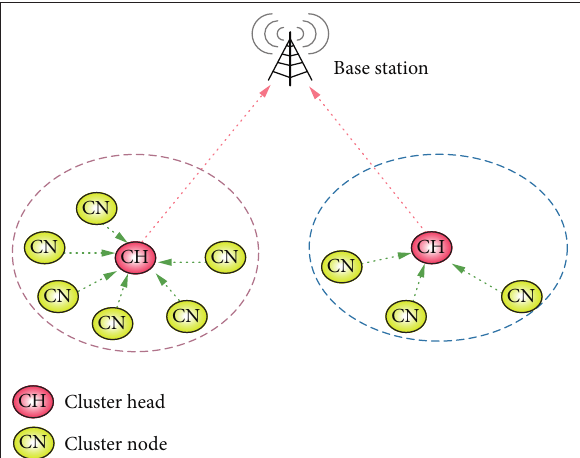
Figure 1: Hierarchical-based routing